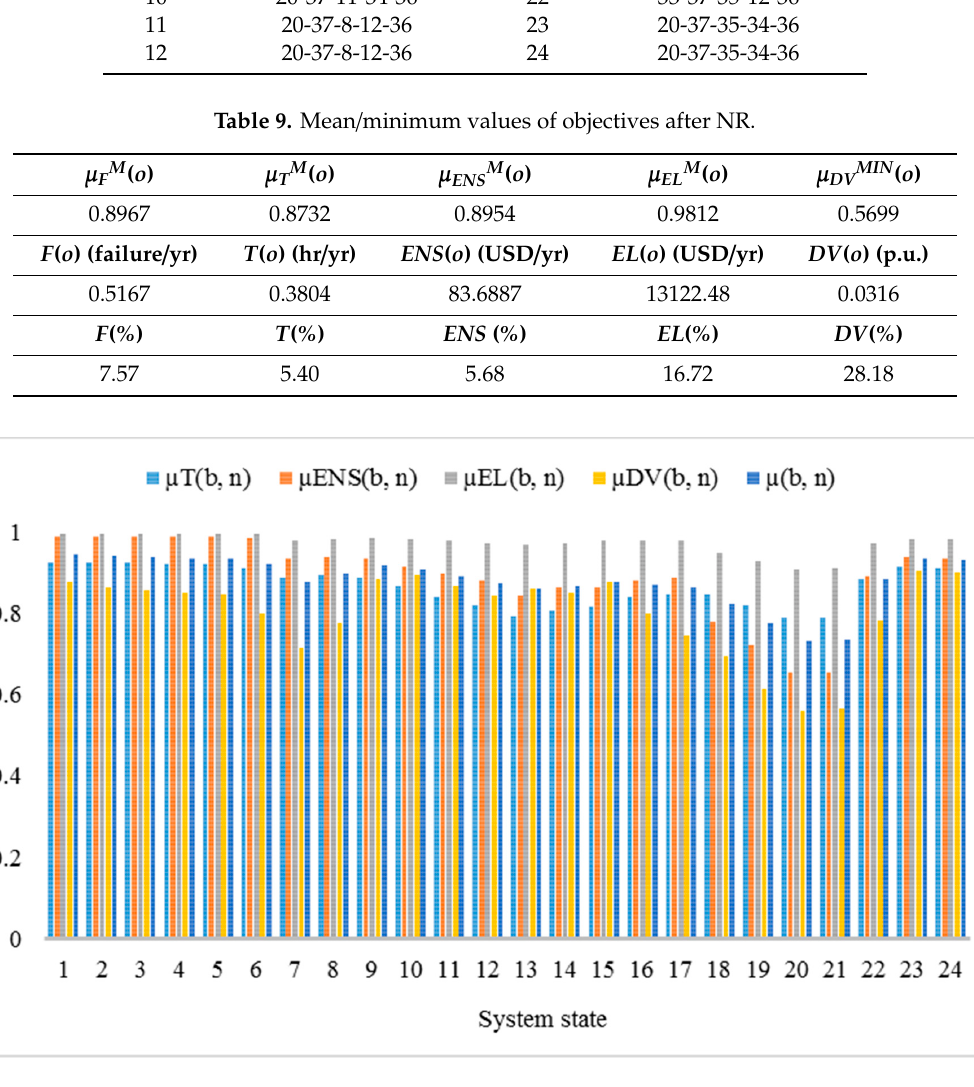
Figure 3. Fuzzy membership functions and overall membership function before NR.